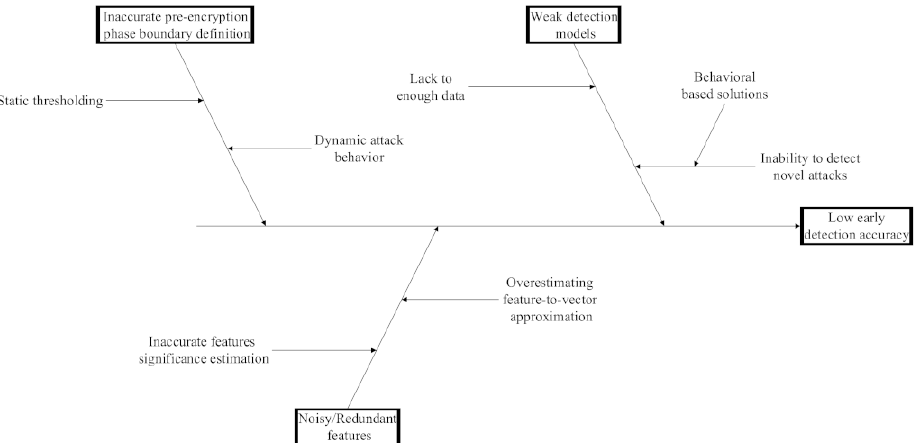
Figure 2. Cause–effect diagram illustrating the limitations in existing crypto-ransomware early detection